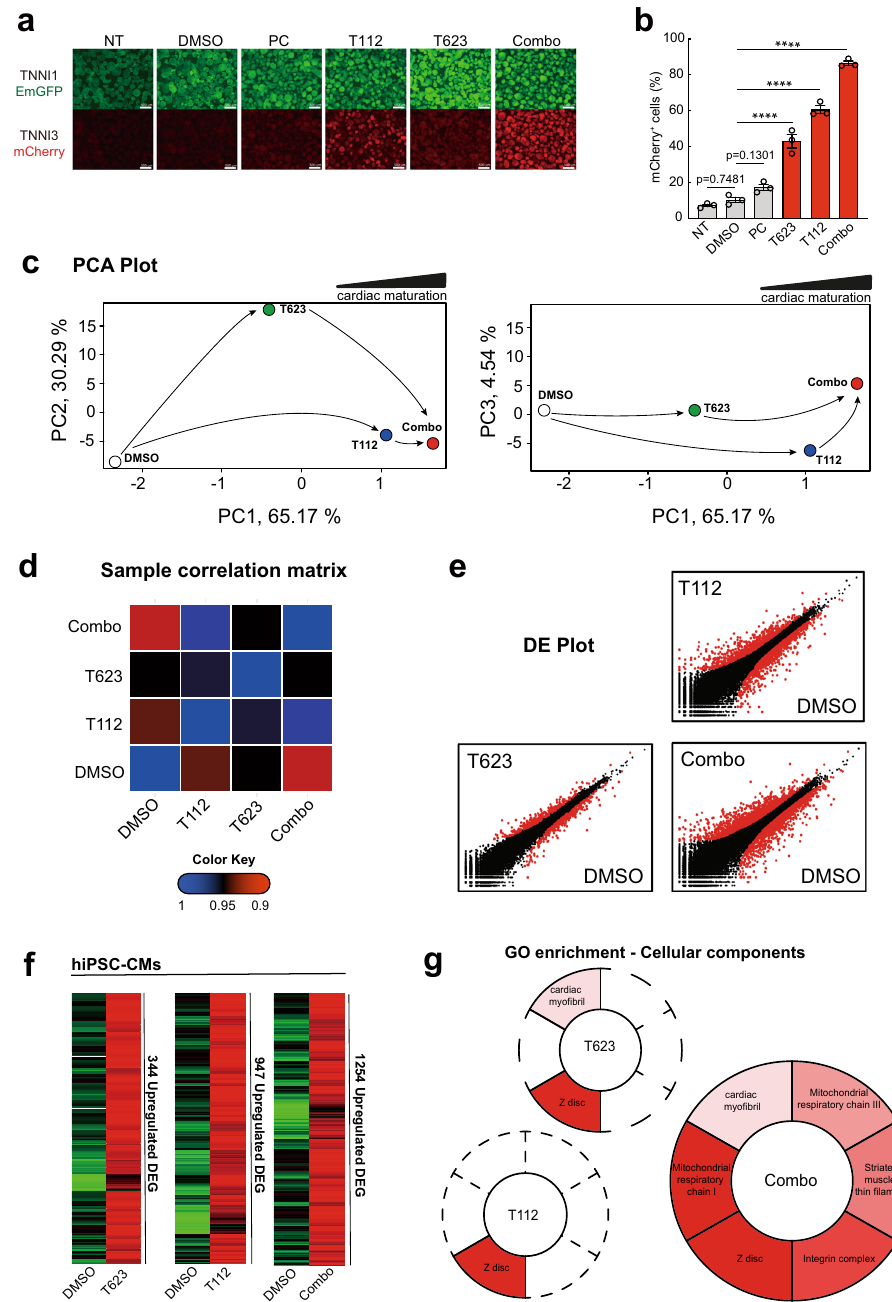
Fig. 3 T112 and T623 enhanced the cardiac maturation of hiPSC-CMs. a Fluorescence images of day-16-derived EBs for TNNI1 EmGFP and TNNI3 mCherry expression. Scale bars: 500 μ m. NT no treatment, PC positive control. b Flow cytometric analysis of day-16-derived cells for TNNI3 mCherry expression. n = 3 independent experiments per group. Data are the mean ± SEM; **** P < 0.0001 compared to DMSO using one-way ANOVA followed by Dunnett ’ s test. NT no treatment, PC positive control. c Principal-component analysis (PCA) in correlation with the maturation of CMs for more than 58,000 genes expressed in the four groups. Data are shown as average PCA for each group. n = 3 independent experiments per group. d Sample correlation matrix resulting from the consensus clustering analysis of mRNA data and showing transcriptomic differences among treatments. Data are shown as averages for each group. n = 3 independent experiments per group. e Volcano plots for DE genes in accordance with the cardiac maturation phenotype. f Summary of upregulated DE genes in either T623/T112-treated CMs or Combo-treated CMs compared to DMSO. The number of upregulated genes (at least 2-fold) is depicted. Left: 344 unique elements detected in the T623-treated CMs compared to DMSO. Middle : 947 unique elements detected in the T112-treated CMs compared to DMSO. Right : 1254 unique elements detected in the Combo-treated CMs compared to DMSO. g Analysis of the top-6 cardiac-related signi fi cant GO terms for the cellular components of T623-, T112- and Combo-treated